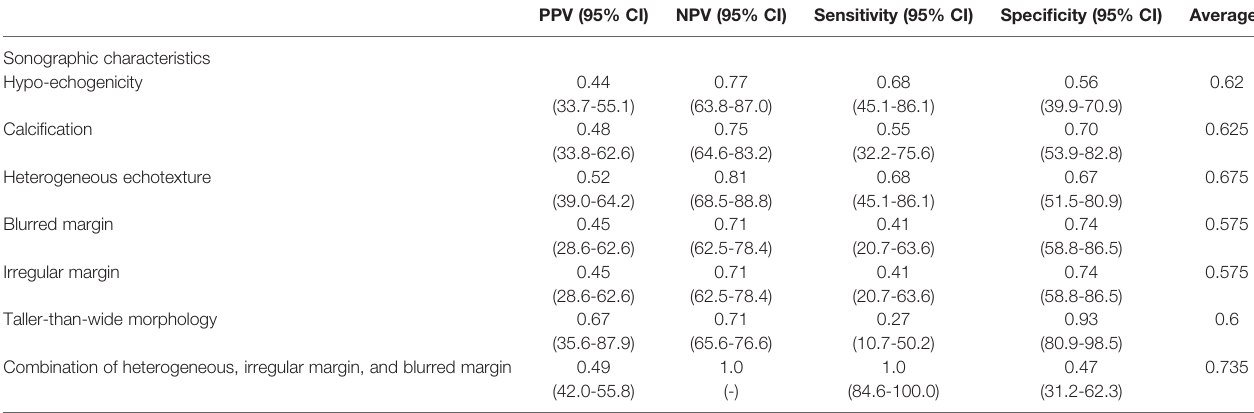
TABLE 3 | Sonographic features used in differentiating benign from malignant conditions in 65 patients with follicular neoplasms.